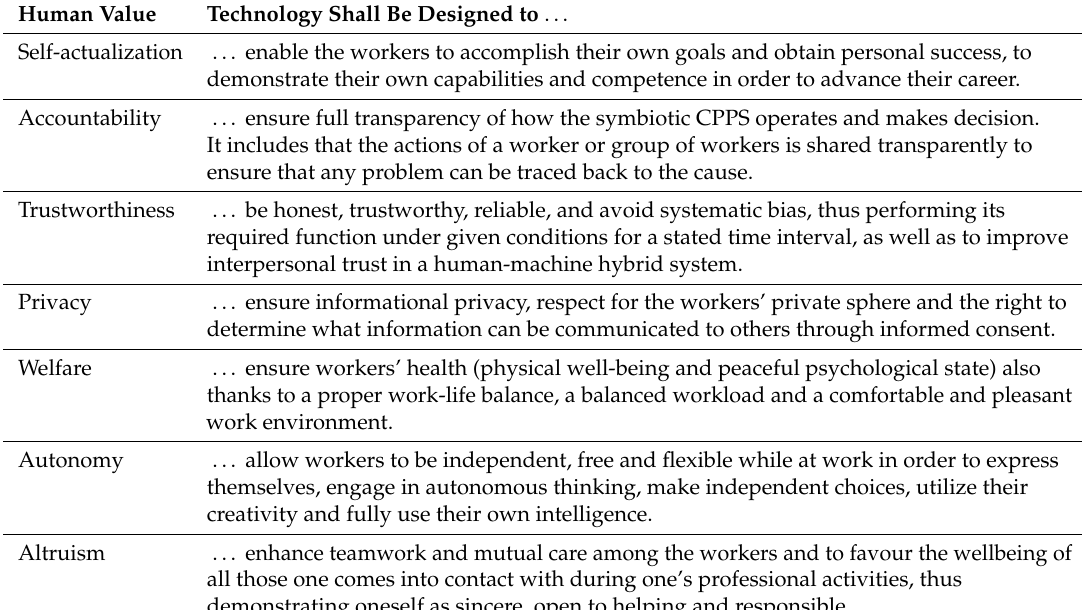
Table 1. Values to uphold during techno-social change towards human–machine symbiosis in Industry